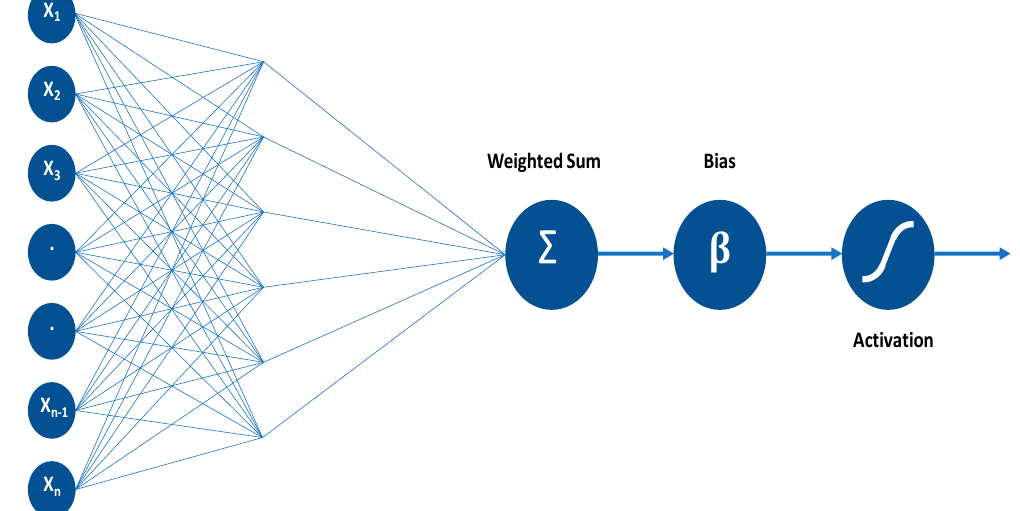
Figure 1. A representation of an artificial neuron